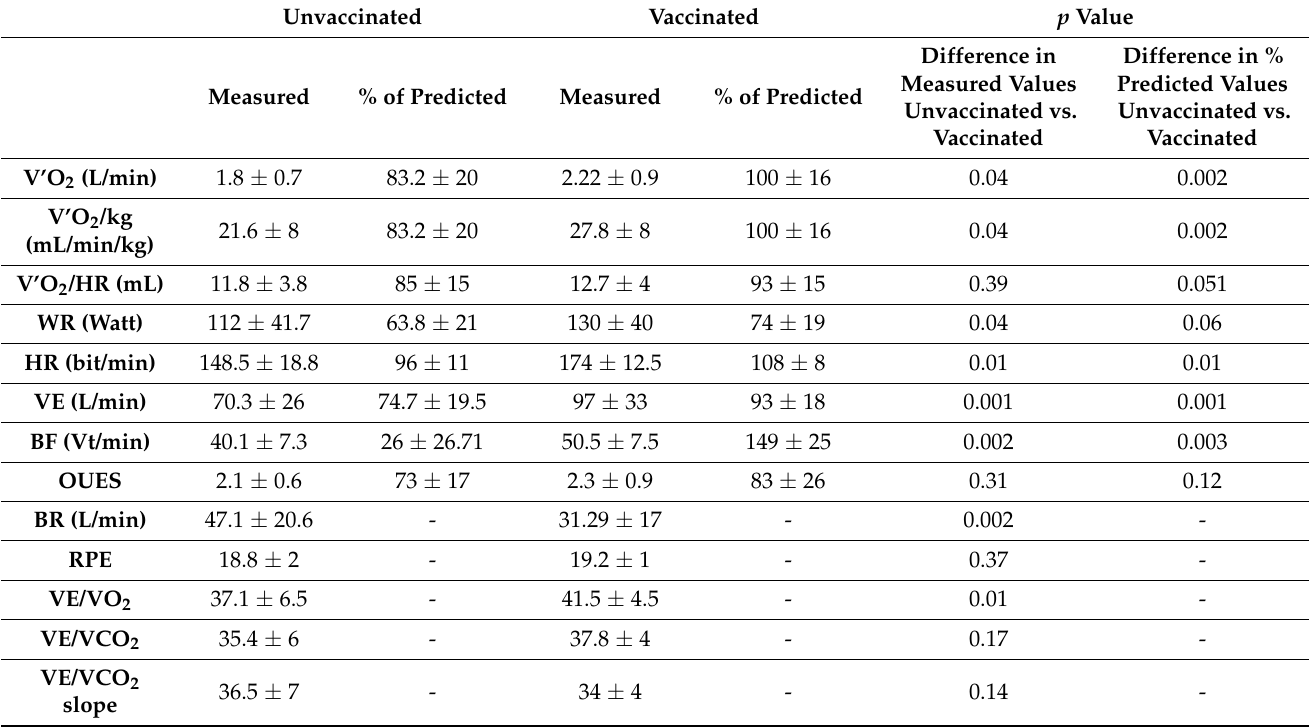
Table 2. CPET parameters at peak exercise. Unvaccinated Vaccinated p Value